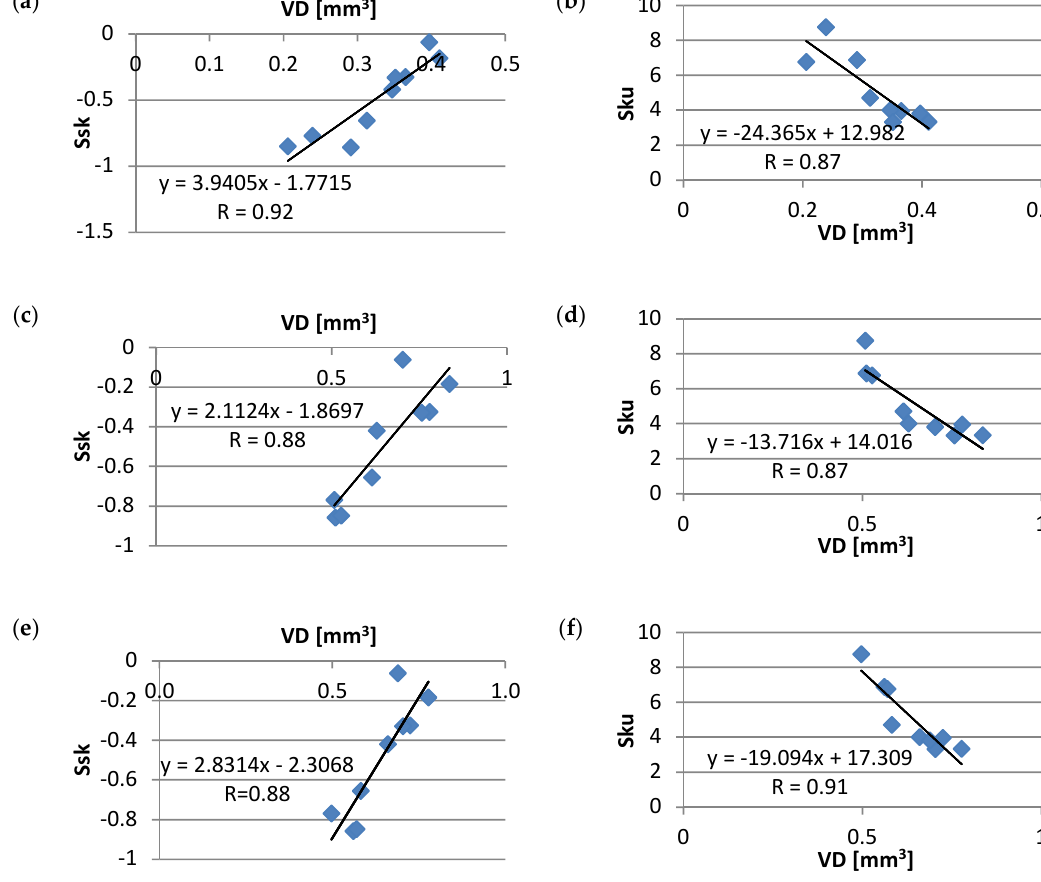
Figure 9. Dependencies between wear volume VD and Ssk ( a , c , e ) and Sku parameters ( b , d , f ) at the sliding speed of: ( a , b ) v = 0.16 m/s; ( c , d ) v = 0.32 m/s; ( e , f ) v = 0.48 m/s.